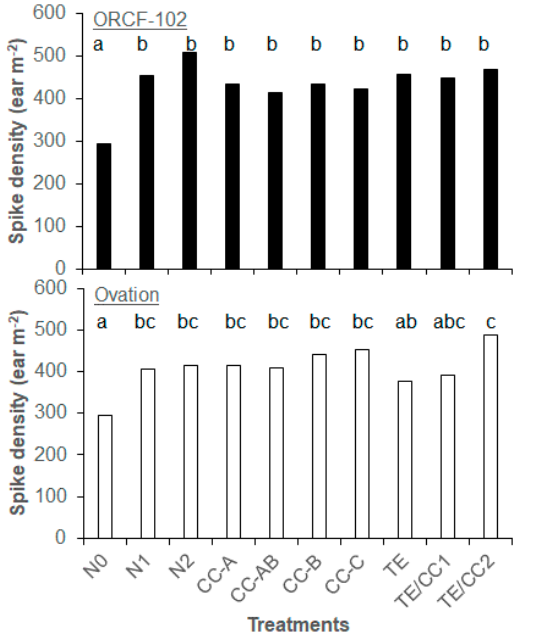
Figure 4. Spike density (ear m − 2 ) of two winter wheat varieties among the treatments across the data of two years in Adkins fine sandy loam soil. N0 = no fertilization; N1 = normal N rate; N2 = high-N rate without PGR application; CC-A = applying CC at GS30-32; CC-AB = applying CC at GS30-32 and GS37-39; CC-B = applying CC at GS37-39; CC-C = applying CC at GS21-26; TE = applying TE at GS30-32; TE/CC1 = applying TE at GS30-32 and applying CC (0.442 L ha − 1 a.i.) at GS37-39; TE/CC2 = applying TE at GS30-32 and applying CC (1.004 L ha − 1 a.i.) at GS37-39. Different letters on the top of each column indicate significant differences among treatments at 5% level according to LSD test.